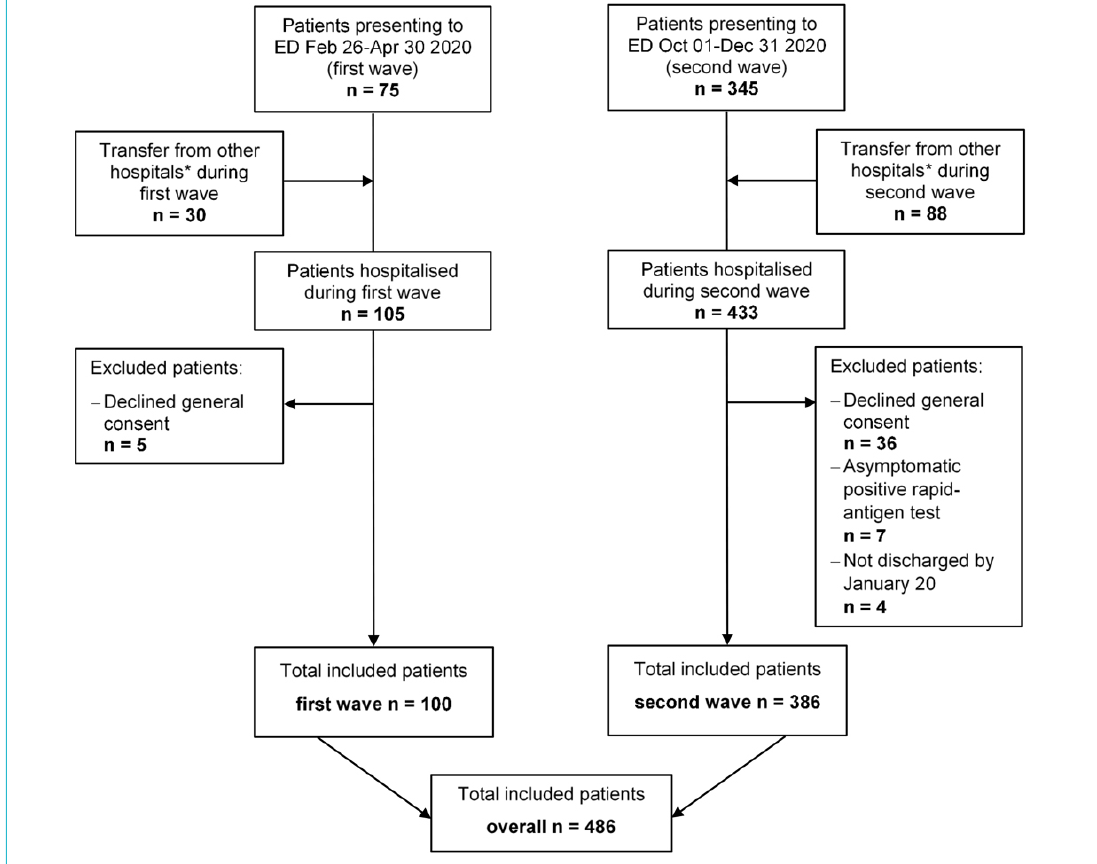
Figure 1: Overview of study flow. A total of 486 patients were included in the final analysis. ED = emergency department * includes psychiatric and rehabilitation care